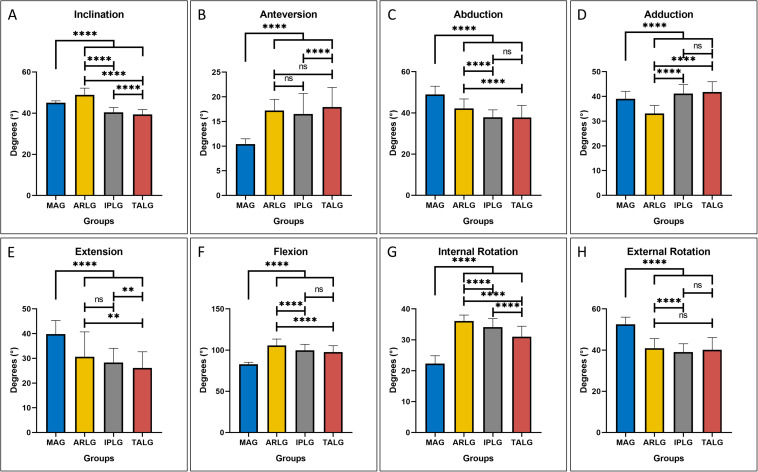
The four-cup positioning guides leading to different cup positioning and hip ranges of motion (HROMs). On the two parameters of cup positioning, great significance was observed on both inclination (A) and anteversion (B) by the four guides. All parameters of HROMs, including abduction (C), adduction (D), extension (E), flexion (F), internal rotation (G), and external rotation (H), were significant by the four guides. Pairwise comparison results were displayed by asterisk: ns stood for p > 0.05, * stood for p ≤ 0.05, ** stood for p ≤ 0.01, *** stood for p ≤ 0.001, and **** stood for p ≤ 0.0001.